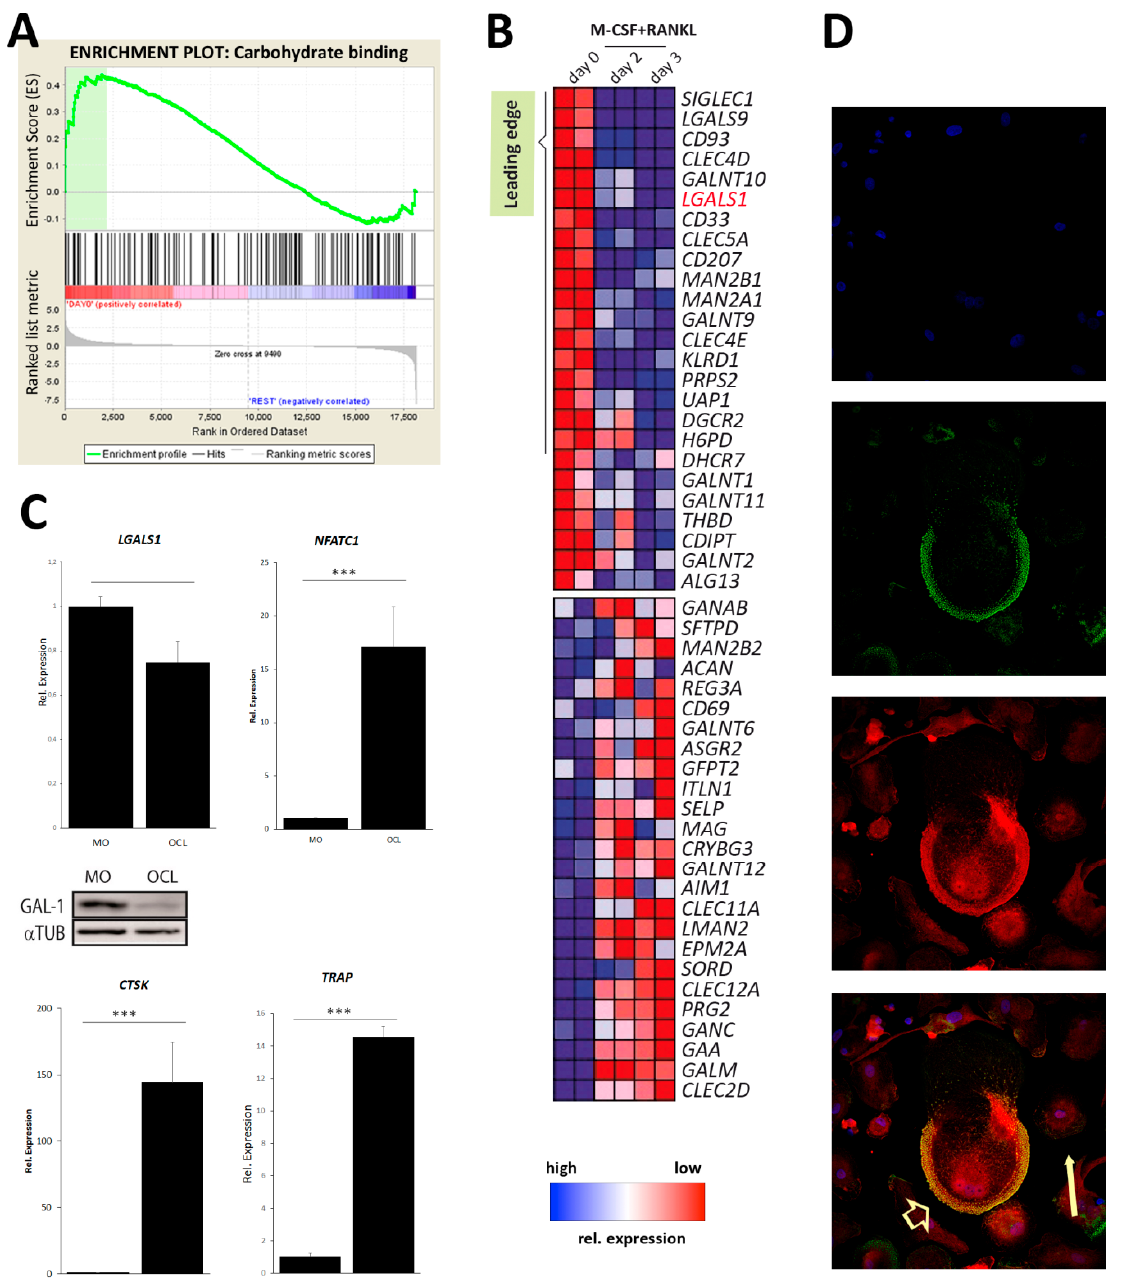
Figure 1. Galectin-1 expression decreases during osteoclast differentiation. ( A ) GSEA representing the distribution of the carbohydrate gene set in monocytes/macrophages versus osteoclasts (OCLs) and demonstrating that OCL precursors are higher enriched in carbohydrate binding proteins compared to mature OCLs. ( B ) Expression data set sorted by correlation with phenotype, the corresponding heat map, the gene tags and the leading-edge subset. Genes are ranked based on the correlation between their expression and the class distinction. ( C ) qPCR analyses of gal-1, including western blot analysis and OCL reference gene (NFATc1, cathepsin K, TRAP) expression in RAW-264.7-derived osteoclast cultures (MO: monocytes; OCL: osteoclasts; α TUB: α -tubulin). Data are representative of three ( n = 3) biologically independent experiments and represented as mean +/ − standard error. * p < 0.05; ** p < 0.01; *** p < 0.001. ( D ) Localization of gal-1 in mononuclear precursors (arrow) and mature OCLs (arrow head) (top to bottom: nucleus; actin, galectin-1, merge). (magnification: 60 × ) Representative images out of three ( n = 3) independent experiments are shown.